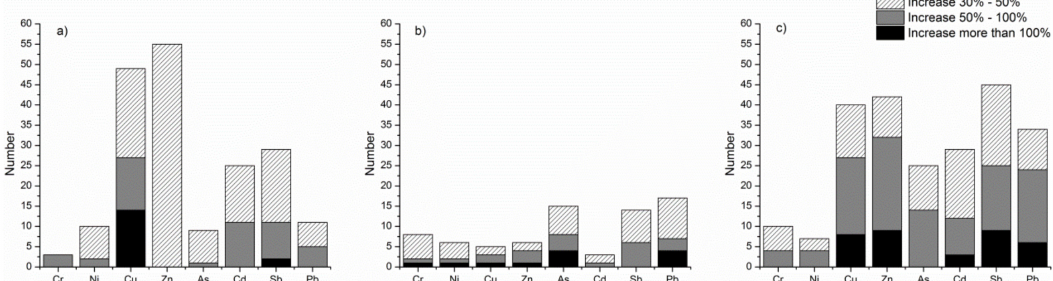
Figure 6. Numbers of nonlinear increase combinations in ( a ) urban core regions, ( b ) suburban regions, and ( c ) exurban regions. “Increase” means the comparison between the q value of interactions and the sum of two impact factors. “Increase 30–50%” low-level non-linear enhancement, “Increase 50–100%” means mid-level non-linear enhancement, “Increase >100%” means high-level non-linear